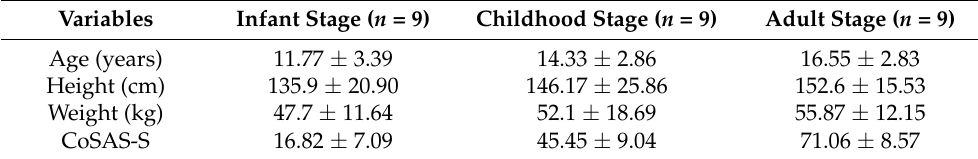
Table 2. General characteristics in